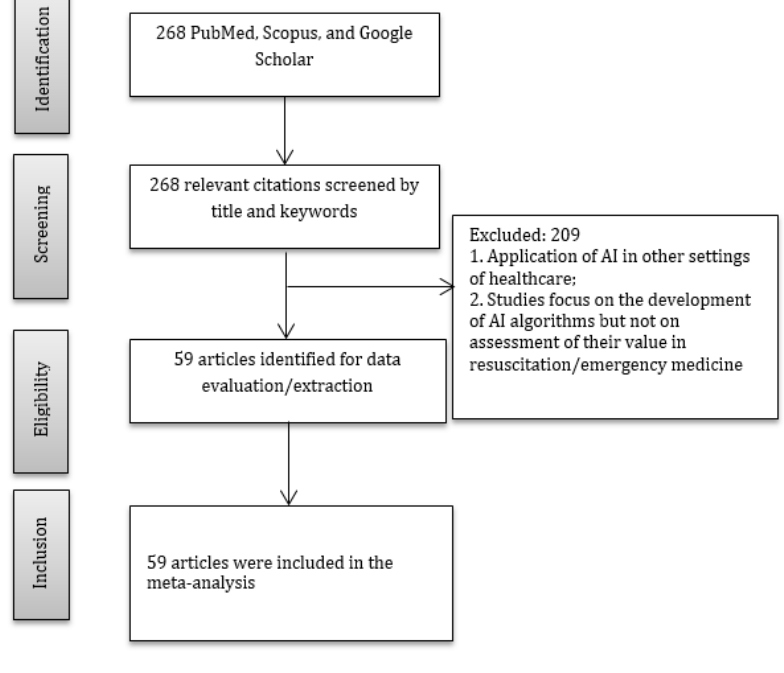
Figure 1. PRISMA Figure 1. PRISMA diagram.